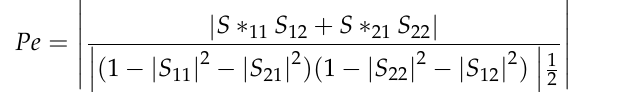
Figure 14 . Measurement and simulation of the enveloped correlation coefficient (ECC) . Figure 14. Measurement and simulation of the enveloped correlation coefficient